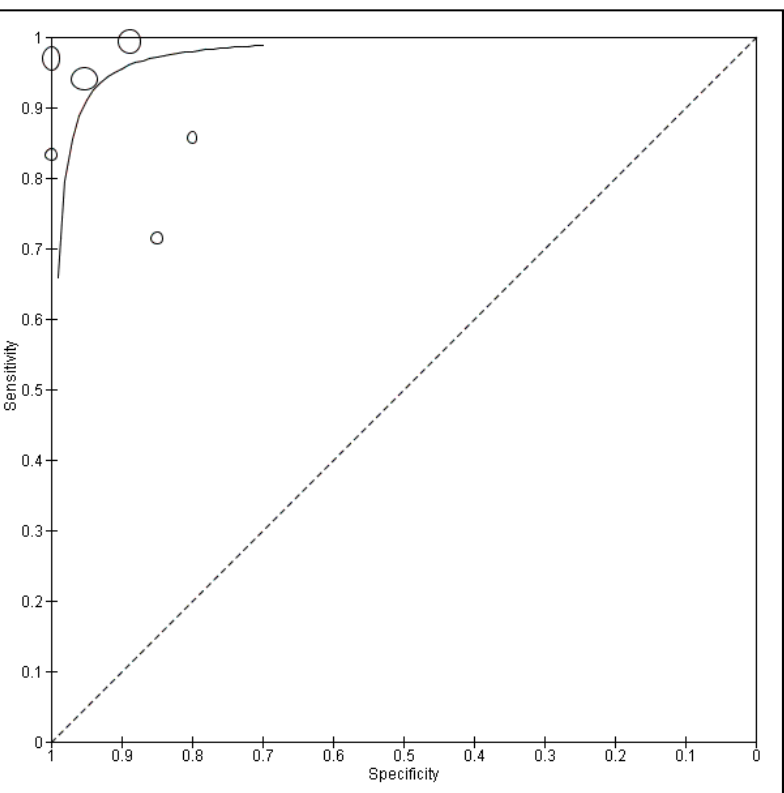
Figure 3. HSROC (hierarchal summary receiver operating characteristic) curve of sensitivity (Y-axis) vs. specificity (X-axis) of CLE for diagnosing OSCC. Points characterize the sensitivity and specificity of a single study. The sample size of the study was proportional to the size of the point. The solid line displays the summary ROC curve.